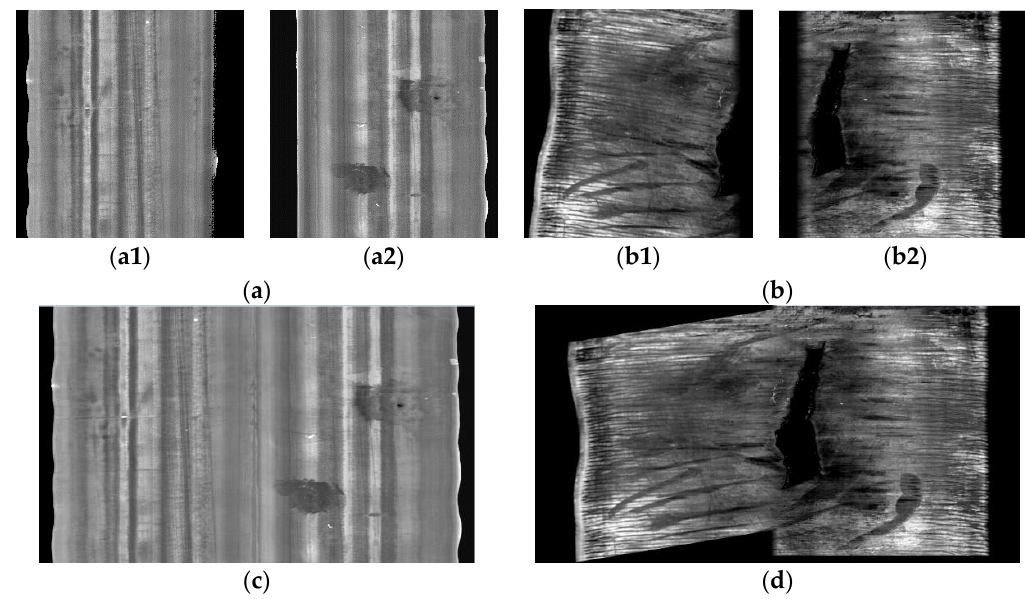
Figure 16. Stitching effect of AMIM method. ( a ) Two view image group 1. ( a1 ) Left image. ( a2 ) Right image. ( b ) Two view image group 2. ( b1 ) Left image. ( b2 ) Right image. ( c ) Two view image group 1 mosaic image. ( d ) Two view image group 2 mosaic